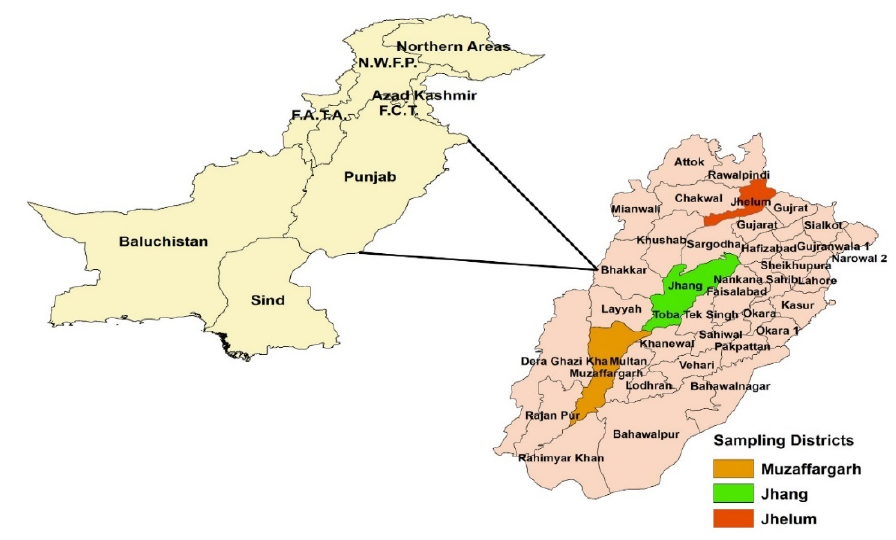
Figure 2. Map of study area.